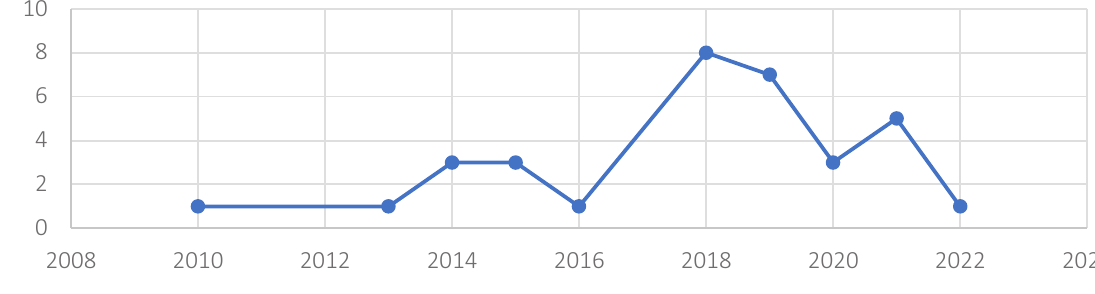
Figure 2. Publication trends by